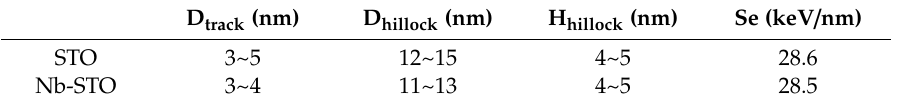
Table 2. Approximate values of ion track diameter (D track ), hillock diameter (D hillock ), and hillock height (H hillock ) in SrTiO 3 (STO) and 0.5 wt% niobium-doped STO (Nb-STO). The corresponding S e values are also